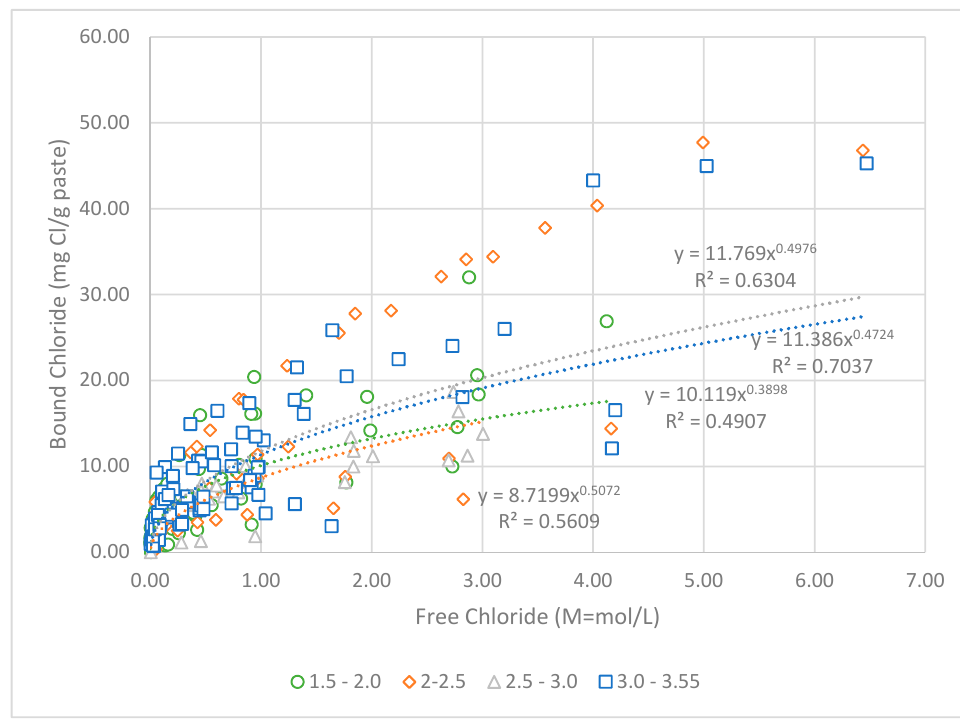
Figure 15. Bound Chloride versus free chloride for different CaO/SiO 2 ratios.